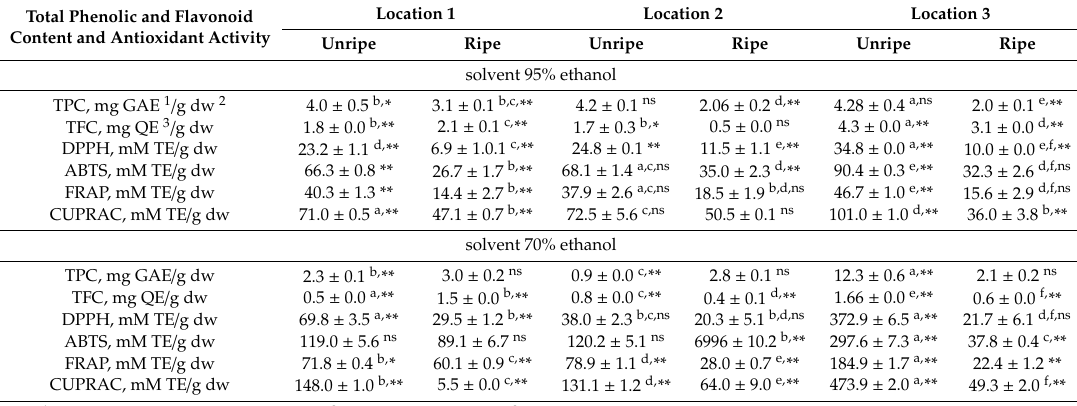
Table 6. Total phenolic content (mg GAE / g dw), flavonoid content (mg QE / g dw), and antioxidant activity (mM TE / g dw) of J. excelsa unripe and ripe galbuli from three collection sites in Bulgaria (mean ± SD). For each column, within the same series (ripe or unripe) di ff erent lower case letters indicate significantly di ff erent at p ≤ 0.05 as measured by Tukey’s multiple range test. *( p < 0.05) and **( p < 0.01) indicate significant di ff erences between ripe and unripe (Student’s t